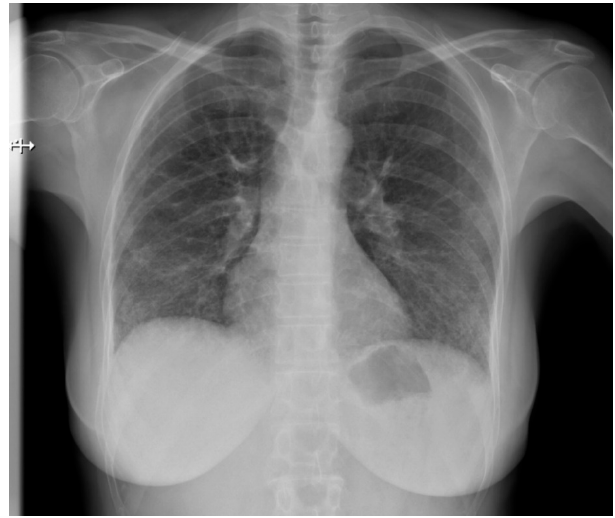
Figure 3. P ‐ A view of the chest radiograph in a patient with systemic sclerosis demonstrates mod ‐ erate pulmonary fibrosis. The pulmonary arteriography (right heart catherization) remains the gold